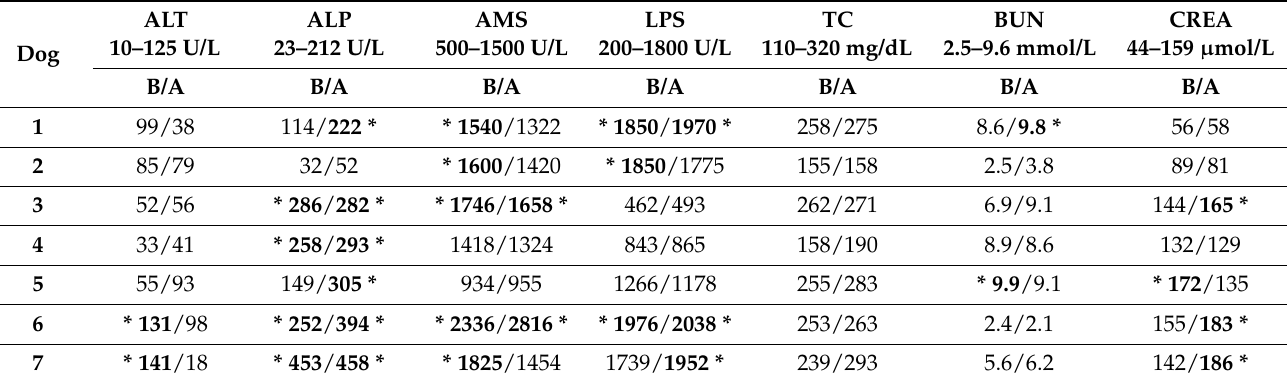
Table 7. Values of the biochemical parameters in the second group of dogs before ( B ) and after ( A )